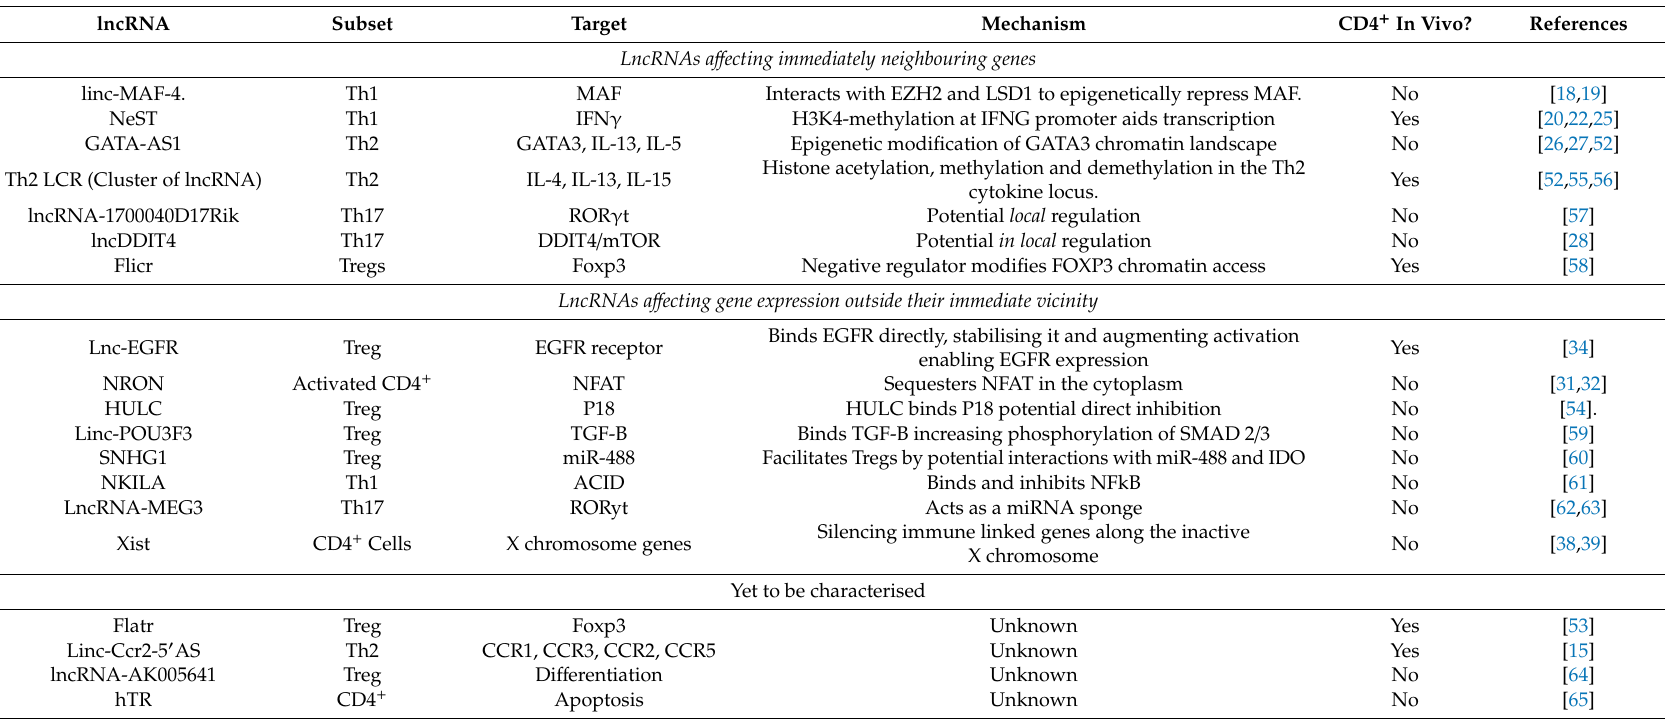
Table 1. lncRNAs known to influence CD4 + T cell